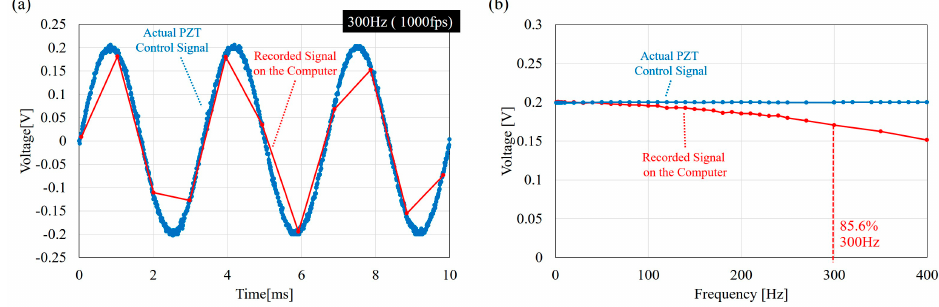
Figure 5. The signal distortion due to the limit of temporal resolution in C program. ( a ) An example of distorted signal at 300 Hz where the input signal is generated at the rate of 100 kHz while the sampling rate on the computer is only 1 kHz; and ( b ) the comparison of the sinusoidal amplitudes on the PZT actuator and on the computer. The computer side remains only 85.6% at 300 Hz.